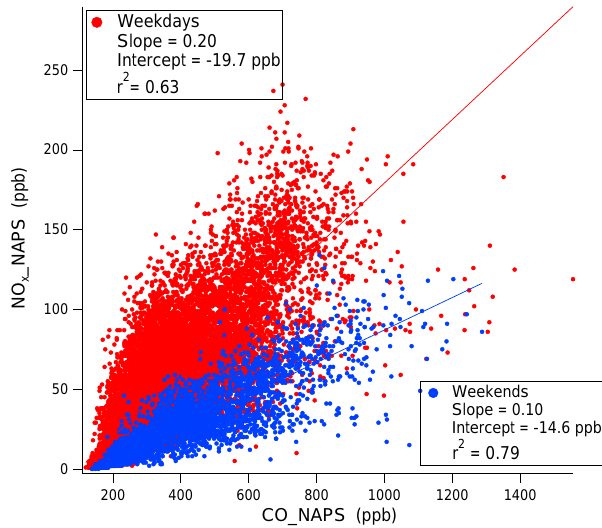
Figure 10. Scatterplot of NO x vs. CO mixing ratios from the NAPS on weekdays (red) and weekends (blue). Lines are the linear regres- sion results for weekdays (red) and weekends